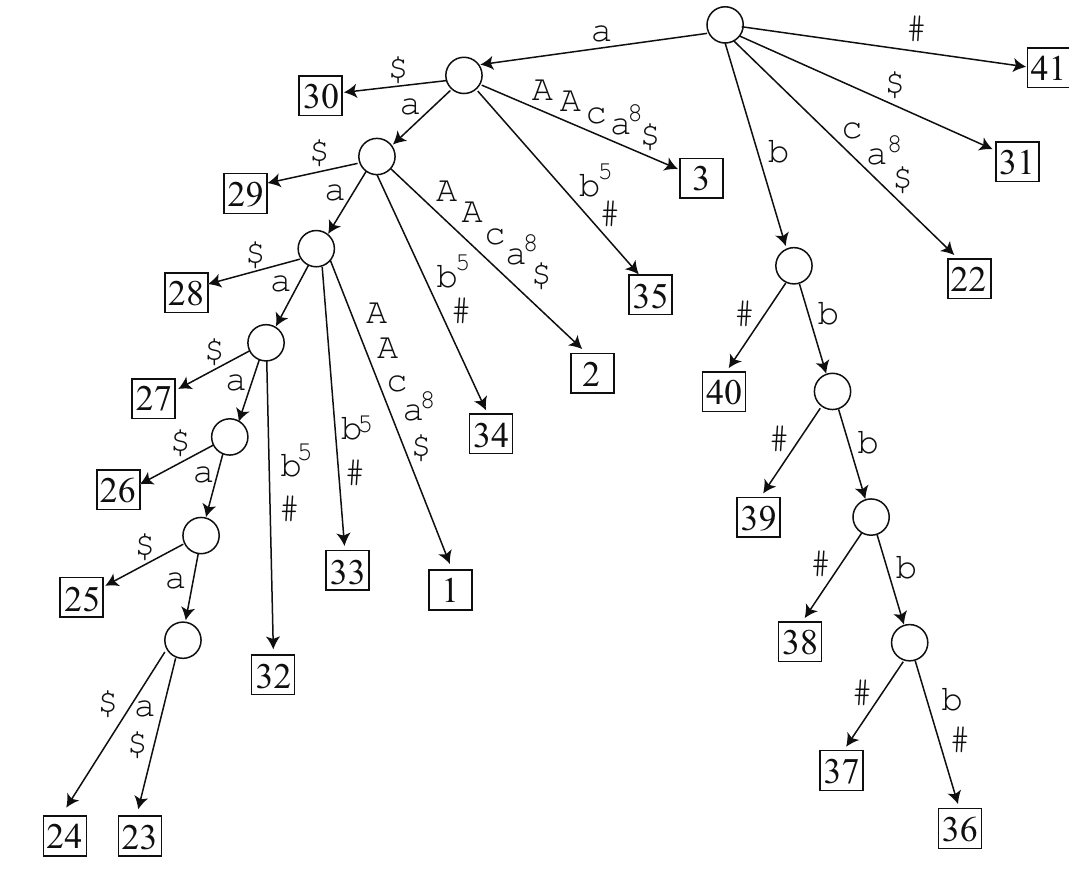
= aaa AA caaaaaaaa $ aaaabbbbb # 1